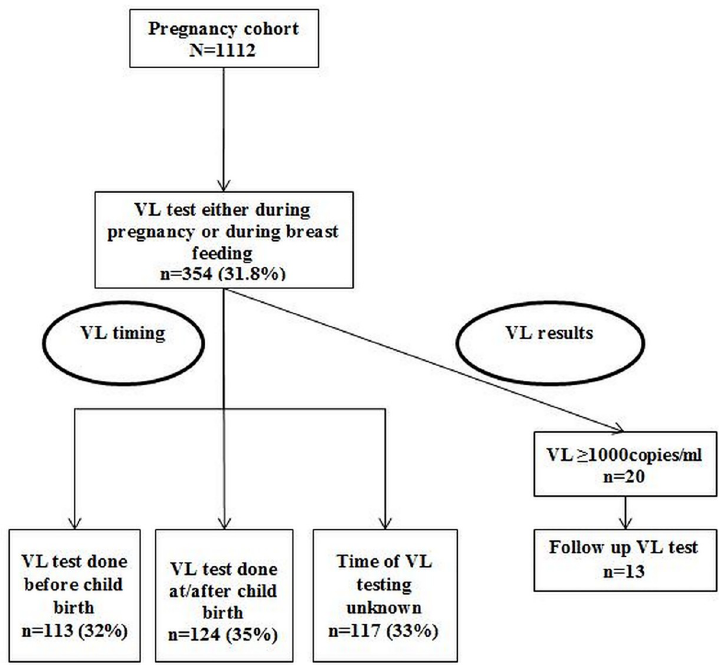
Fig 3. Flowchart describing the viral load testing among the pregnancy cohort (living with HIV and on ART) included in the study, Mazowe district, Zimbabwe (2017). VL- Viral load. Included those i) already on antiretroviral therapy before pregnancy and ii) newly diagnosed with HIV during antenatal care and on antiretroviral therapy for at least three months.